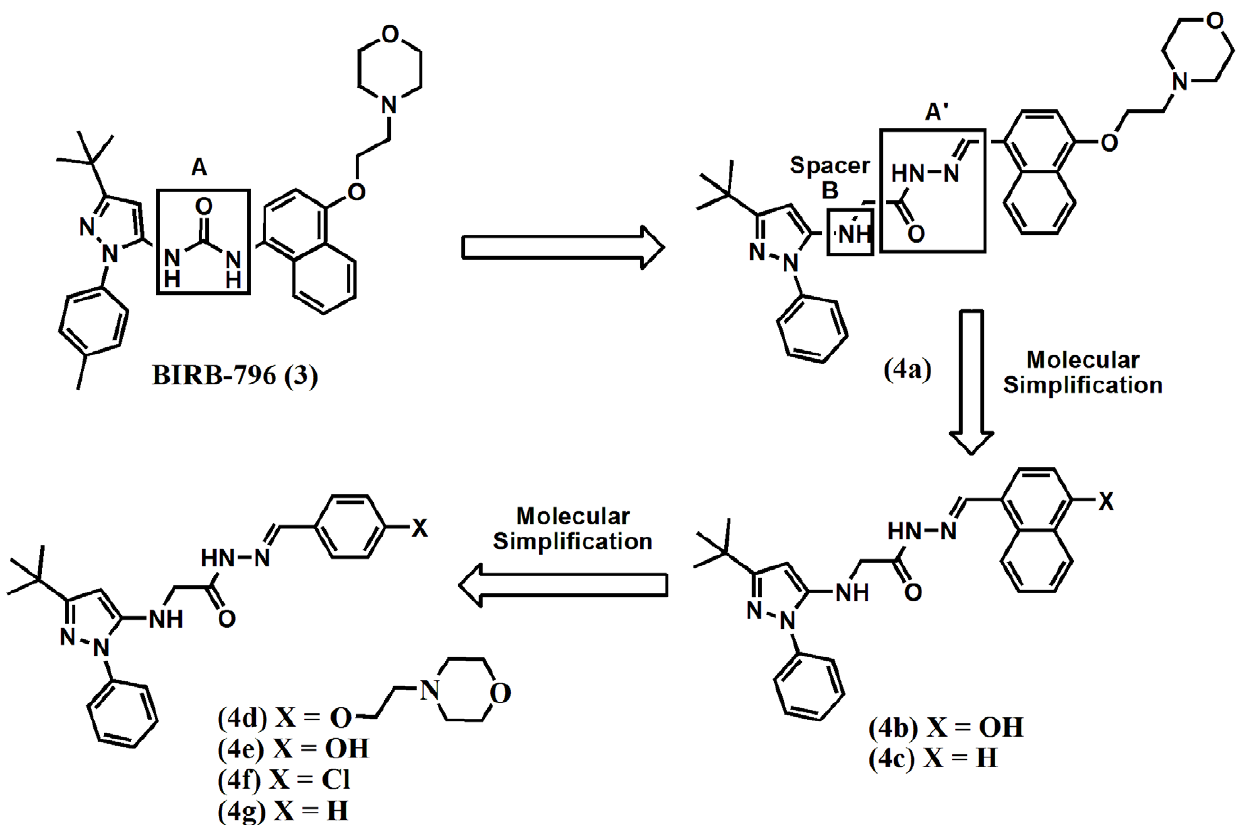
Figure 2. Design concept of novel N -phenylpyrazolyl- N -glycinyl-hydrazones derivatives 4a–g. doi:10.1371/journal.pone.0046925.g002 ring compound 4g (cLogP =5.3), the inhibitory potency increased when lipophilic groups [ para -chloro for 4f (cLogP =6.1), naphthyl for 4c (cLogP= 6.6), 4-hydroxynaphthyl for 4b (cLogP = 6.3) and 4-(2-(naphthalen-1-yloxy)ethyl)morpholine for 4a (cLogP= 6.0) were added. These results indicate that the differences in hydrophobicity of the imine-attached framework play an impor- tant role for the in vitro anti-TNF- a activity of N -phenylpyrazolyl- N -glycinyl-hydrazone derivatives.